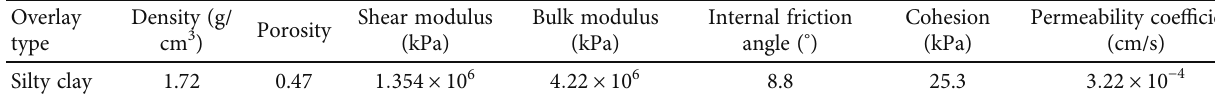
Table 1: Basic physical and mechanical parameters of soil.